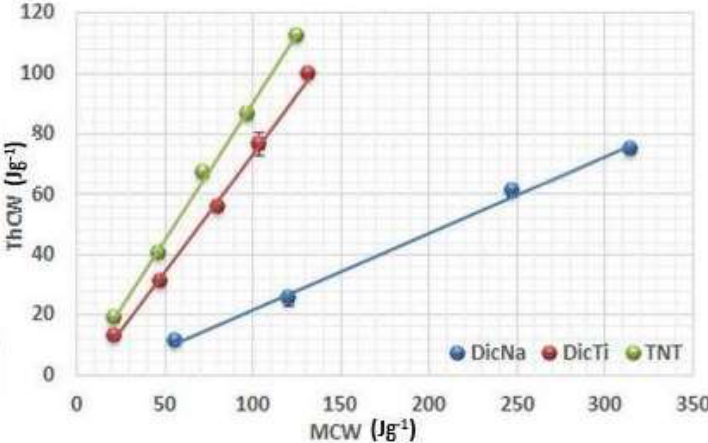
Figure 5. Evolution of ThCW with MCW of TNT, DicNa and DicTi at 50, 100, 150, 200 and 250 MPa compression pressure.